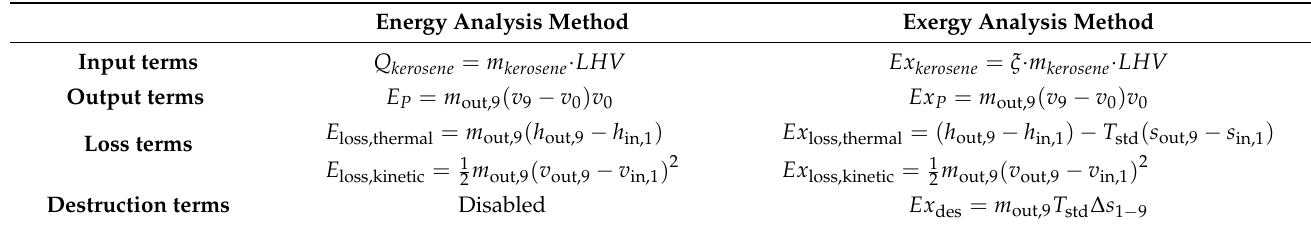
Table 5. Comparison between energy and exergy analysis of aircraft engine.